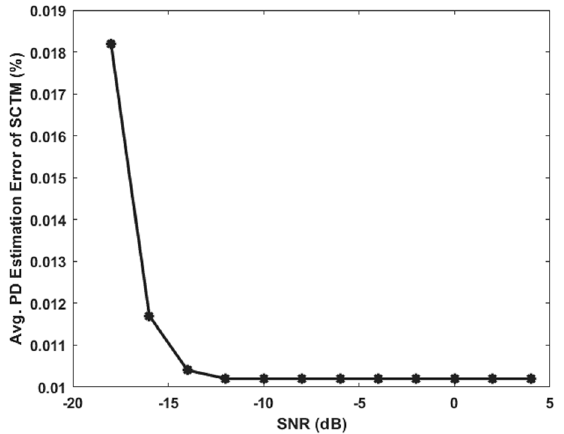
Figure 15. Average PD estimation error versus SNR for the SCTM algorithm.